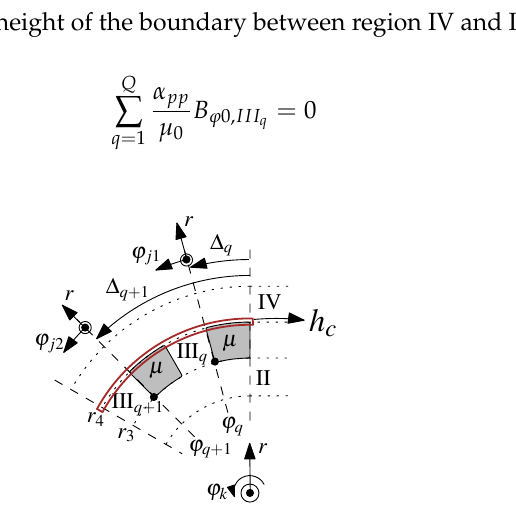
Figure 8. Geometric parameters of the pole-pieces.